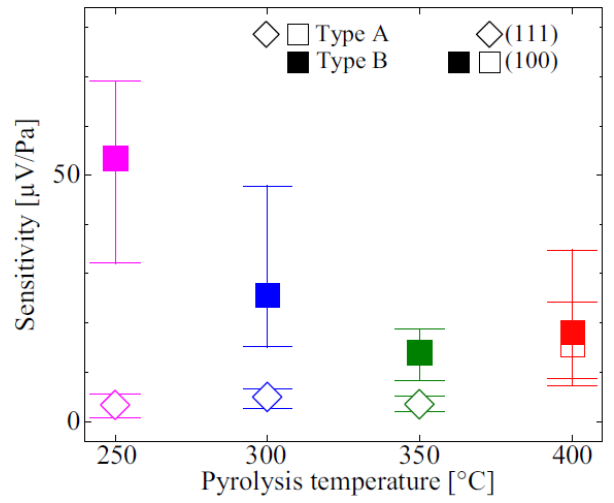
Figure 5. Sensitivity of the sensors having PZT films pyrolyzed at various